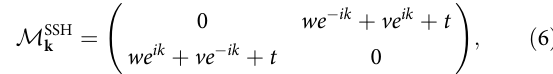
The observed triplon bands are well reproduced by the dis- persion relation given by Eq. (3). The two bands with a large and small structure factor are represented by thick solid and thin dashed curves in Fig. 2a – c, respectively. The parameters J , J A , J A ′ , and J B are selected as 2.61, − 0.24, − 0.16, and − 0.13 meV,